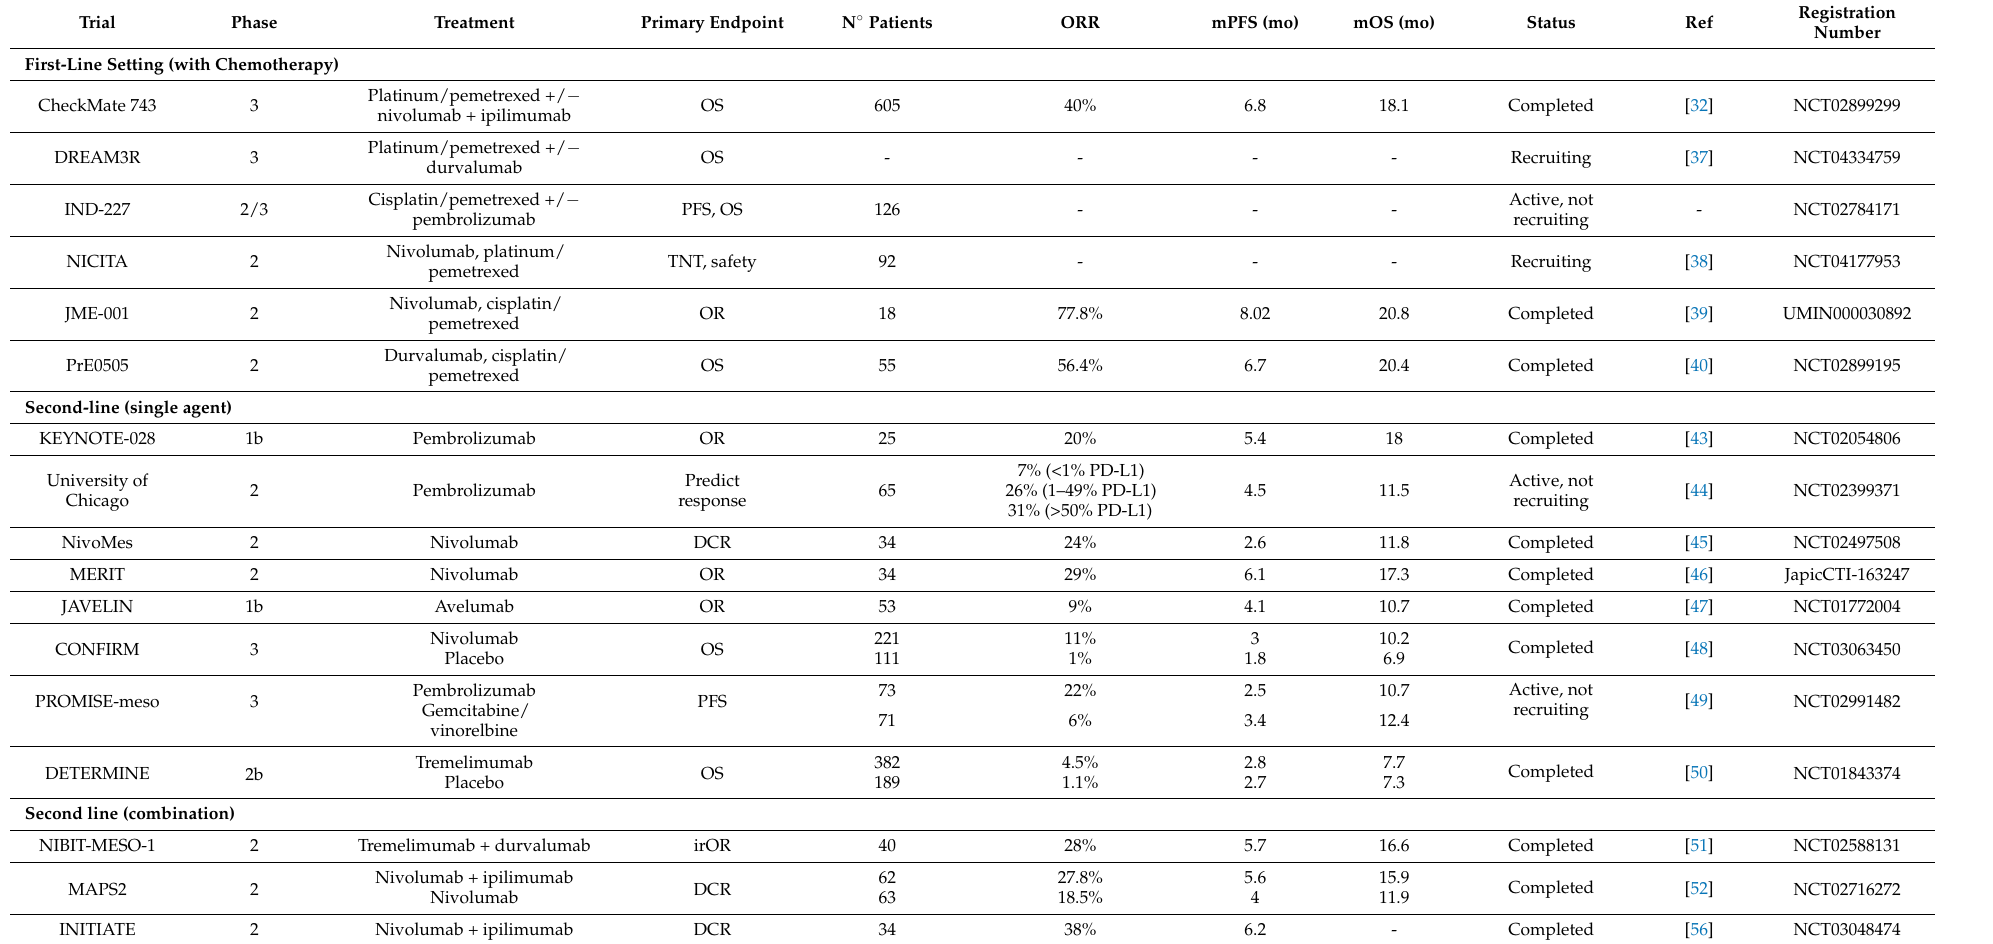
Table 1. Clinical trial results of immune checkpoint inhibitors in malignant pleural